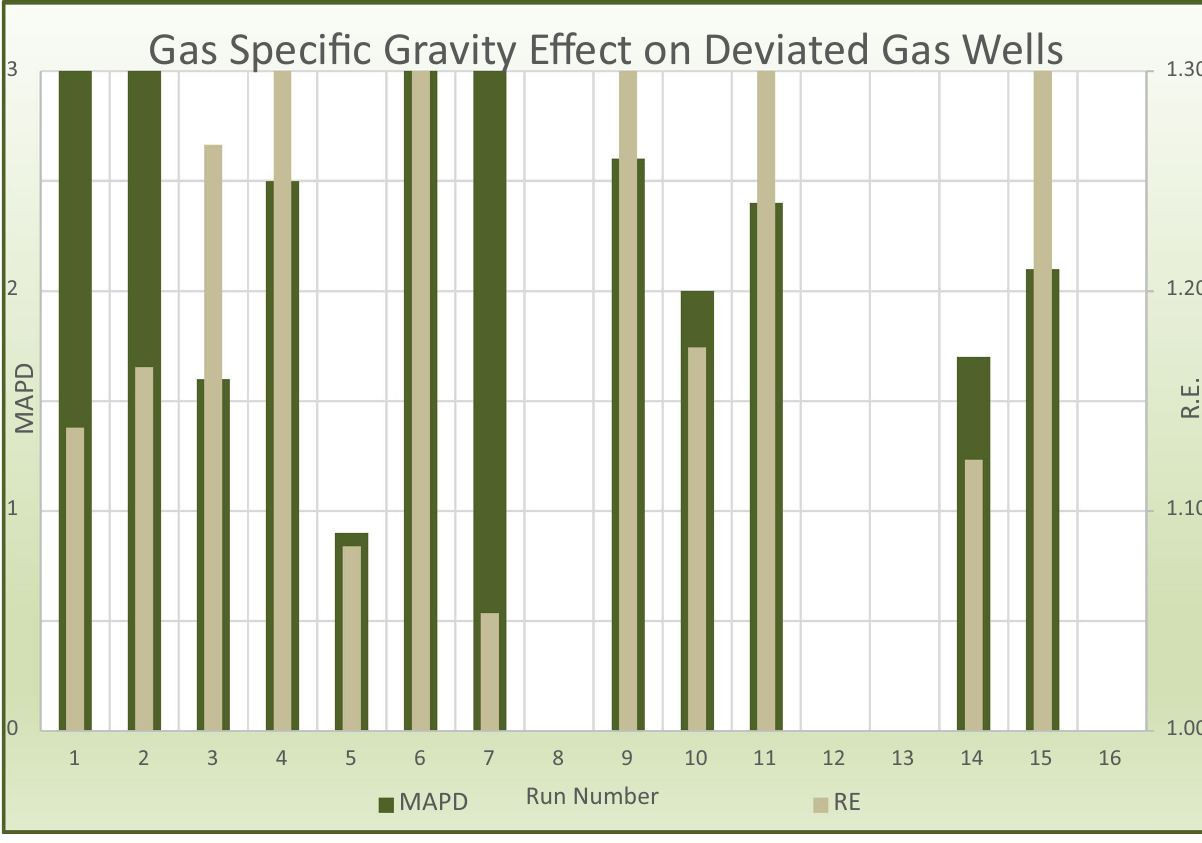
Fig. 8 Effect of gas specific gravity on deviated wells using MAPD and RE methods